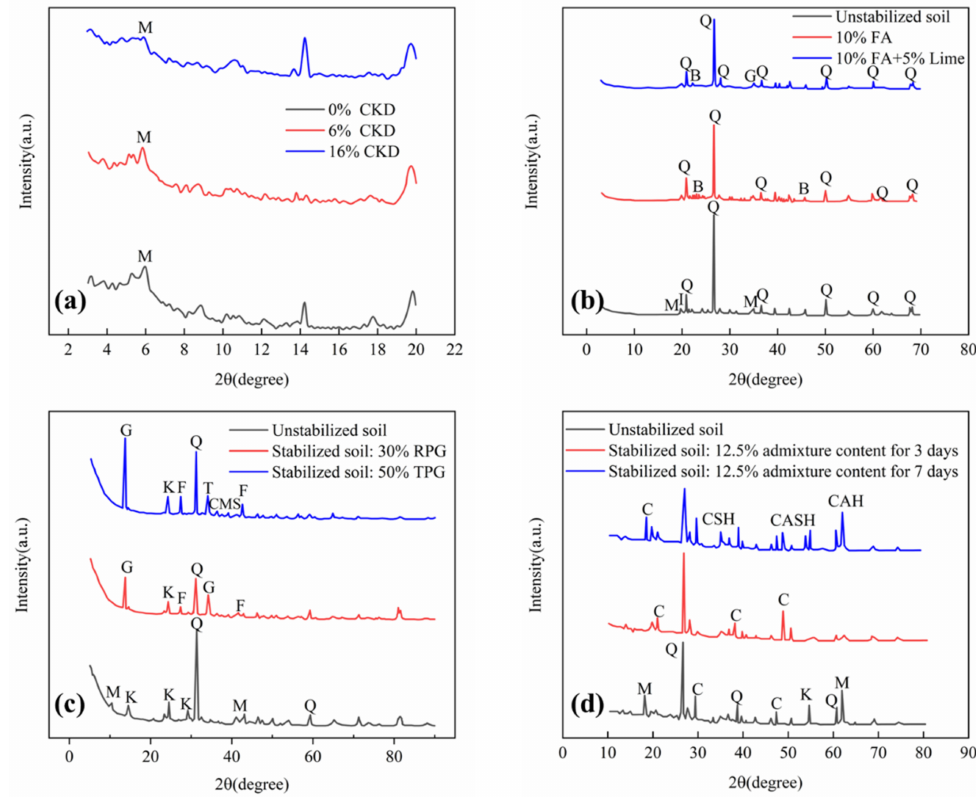
Figure 4. XRD pattern of expansive soil by ( a ) stabilized soil by CKD, ( b ) stabilized soil by FA, ( c ) stabilized soil by PG, and ( d ) stabilized soil by CS. Adapted from [39,42,45,46]. (Note: M: montmo- rillonite; B: bentonite; C: Calcite; Q: quartz; G: gypsum; K: kaolinite; F: feldspar; I: illite; T: trikalsilite; S: sillimanite; CMS: calcium magnesium silicide; CSH: calcium silicate hydrate; CASH: calcium aluminium silicate hydrate; CAH: calcium aluminium